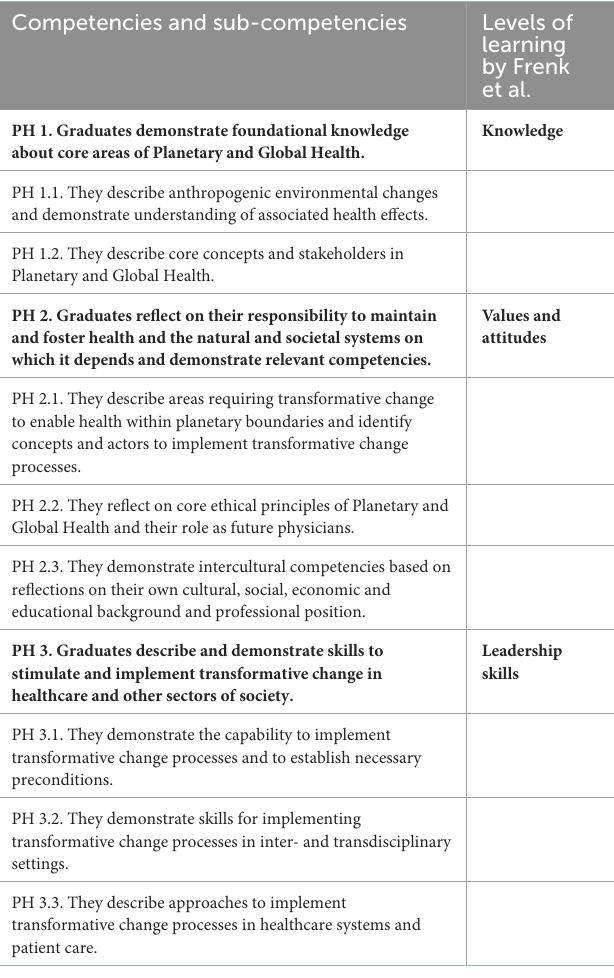
TABLE 1 Competencies and sub-competencies in the catalog of national Planetary Health learning objectives and their alignment with the levels of learning presented by Frenk et al.